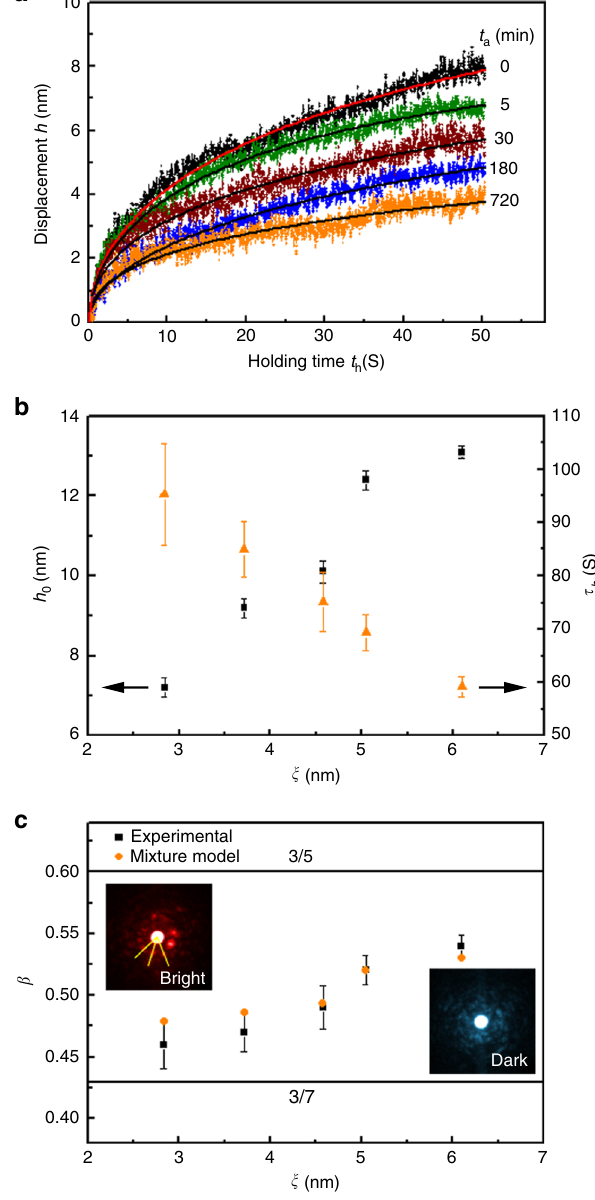
Fig. 4 Strain relaxation measurements. a Indenter displacement h as a function of the holding time t h at a constant loading of 50 mN. The solid lines are fi tting curves of the raw data. b The relaxation amplitude h 0 and the characteristic relaxation time τ h versus the characteristic length ξ of spatial heterogeneity. c The stretching exponent β plotted with the characteristic length ξ . The experimental values of β measured by the strain relaxation are well consistent with the predictions of the mixture model. The top left inset is a representative ABED pattern for the bright regions, and the bottom right inset for the dark regions. The error bars indicate standard